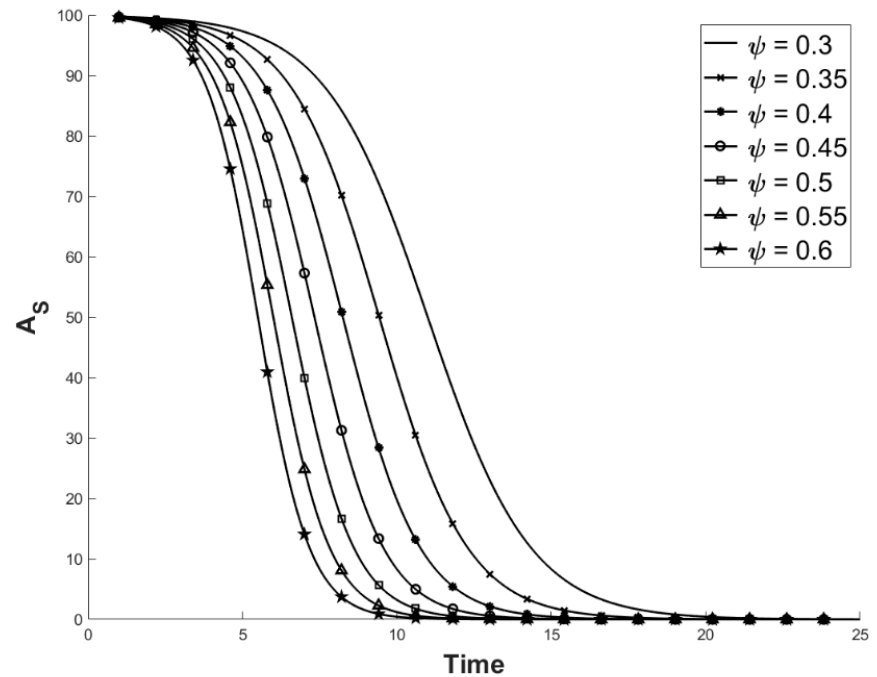
Figure 3. Predicted values of A S with varying values of Ψ while other values remained constant at: σ = 0.3; M N = 0.2; and M D = 0.75. The starting population composition is A I = 1 and A S = 99 and time is in years. A S is the number of susceptible individuals, Ψ is the contact rate, σ is the likelihood of transmission, M N is the natural mortality rate, and M D is the mortality rate associated with ranavirosis.